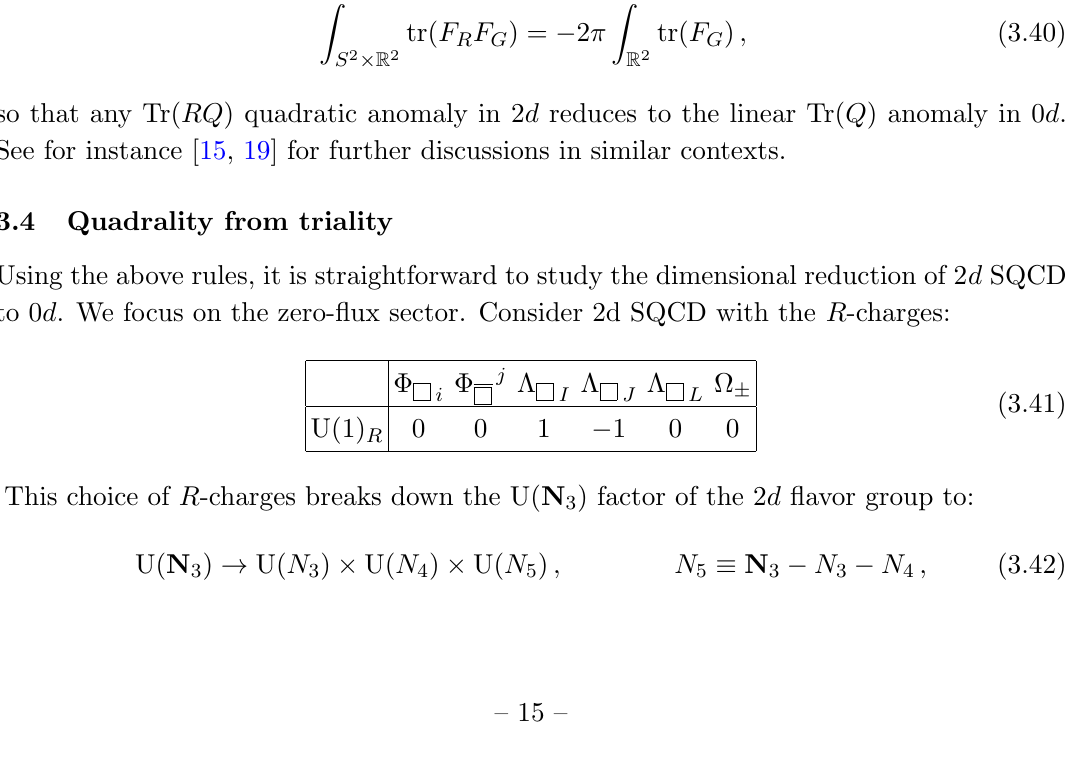
Figure 5 . The reduction with the half-topological twist from (a) deformed 2 d to (b) 0 d = 1 N